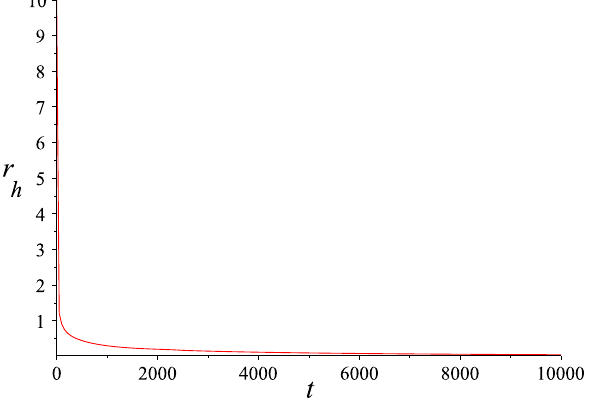
Fig. 4 The evolution of the black hole event horizon radius as function of time. Here we choose initial radius r h ( 0 ) = 10. The black hole parameters are m = 1 = c , c 2 = − 1, l = 1. The black hole